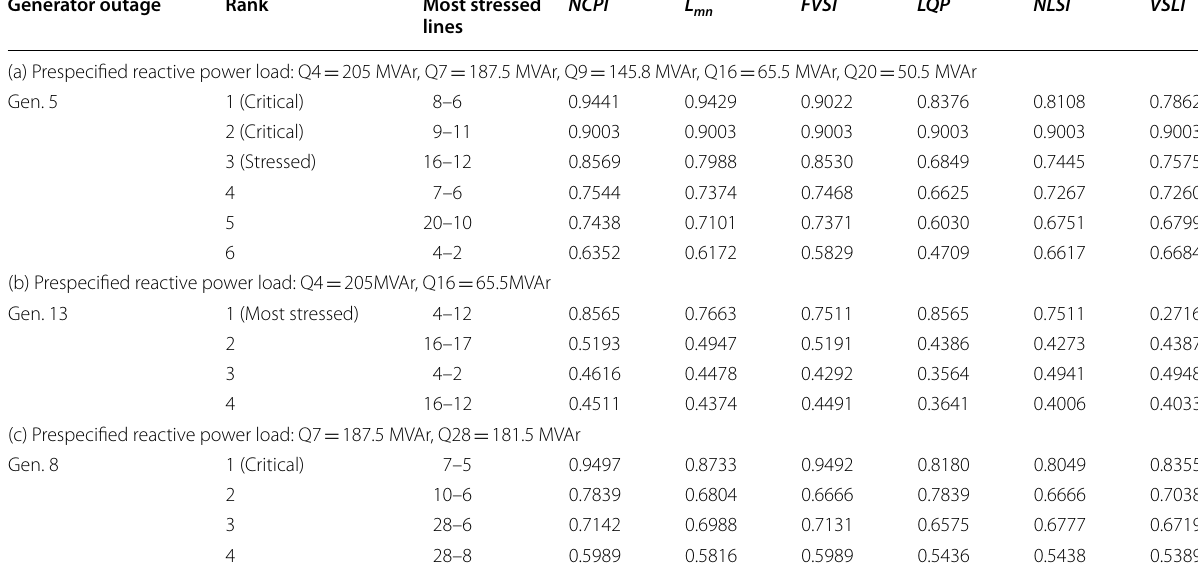
Table 11 Contingency ranking and analysis of the IEEE 30-bus system with pre-specified reactive power load at (a) buses 4, 7, 9, 16 and 20, (b) nodes 4 and 16, (c) nodes 7 and 28 Generator outage Rank Most stressed NCPI L mn FVSI LQP NLSI lines